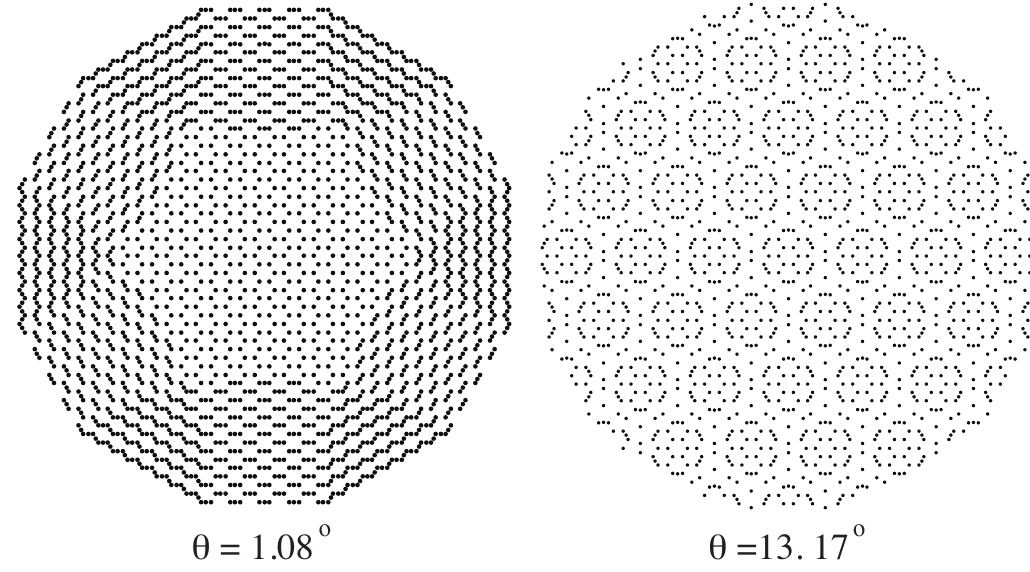
Figure 6. Projected structures obtained for θ = 1.08 ◦ (golden angle) and for θ = 13.17 ◦